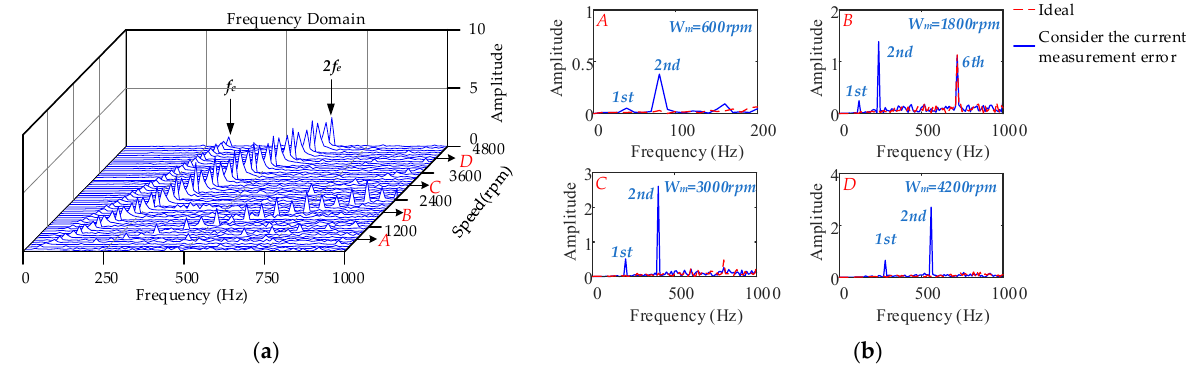
Figure 22. Frequency domain results of electromagnetic torque under different speeds: ( a ) waterfall diagram of electromagnetic torque; ( b ) comparison results of electromagnetic torque.